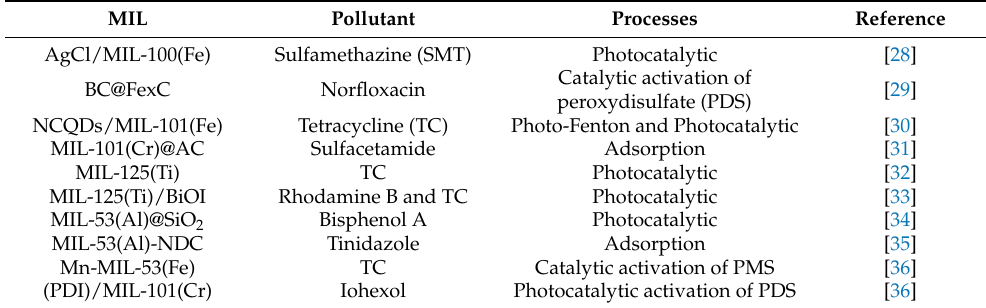
Table 1. Applications of MIL–MOF in wastewater